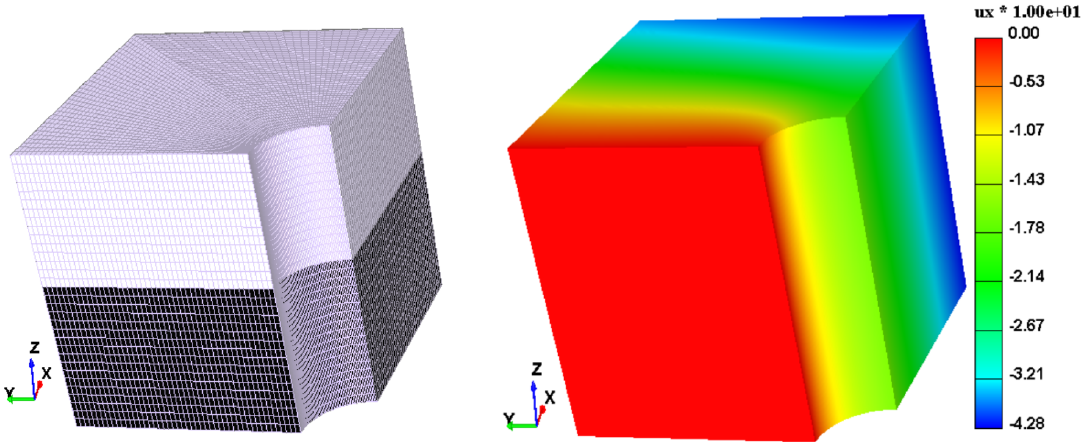
Figure 18. Partitioning ( left ) and parallel ( right ) answer for Bradley 3-D example, ( u x (in)).